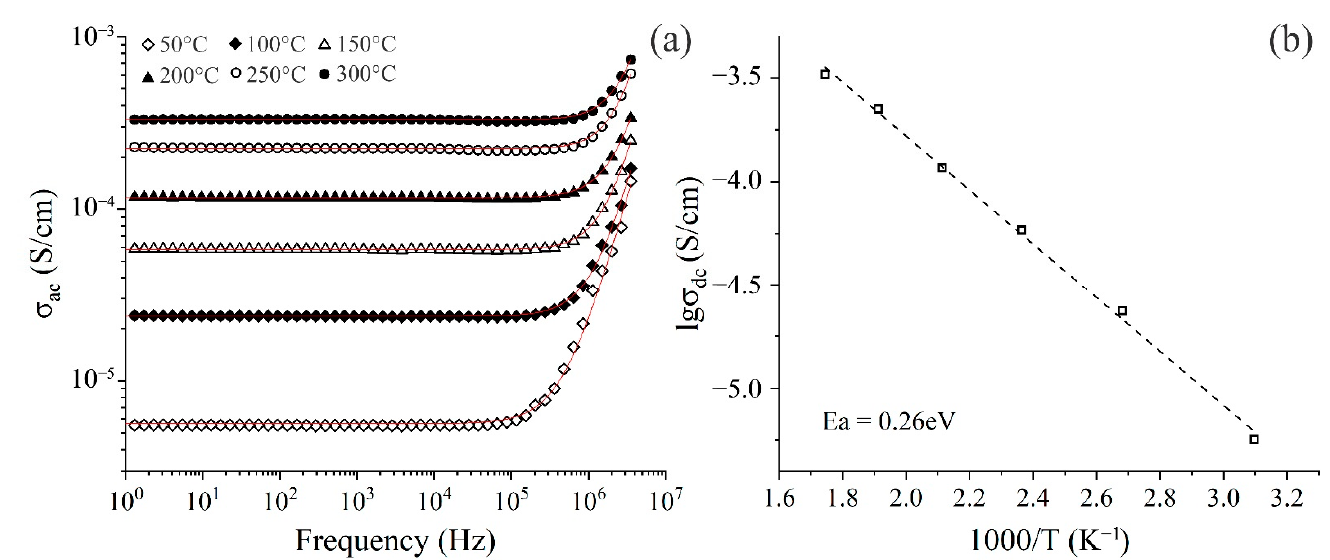
Figure 9. Frequency dependencies of the printed V 2 O 5 film conductivity at various temperatures ( a ); Temperature dependence of conductivity for the film ( b ).